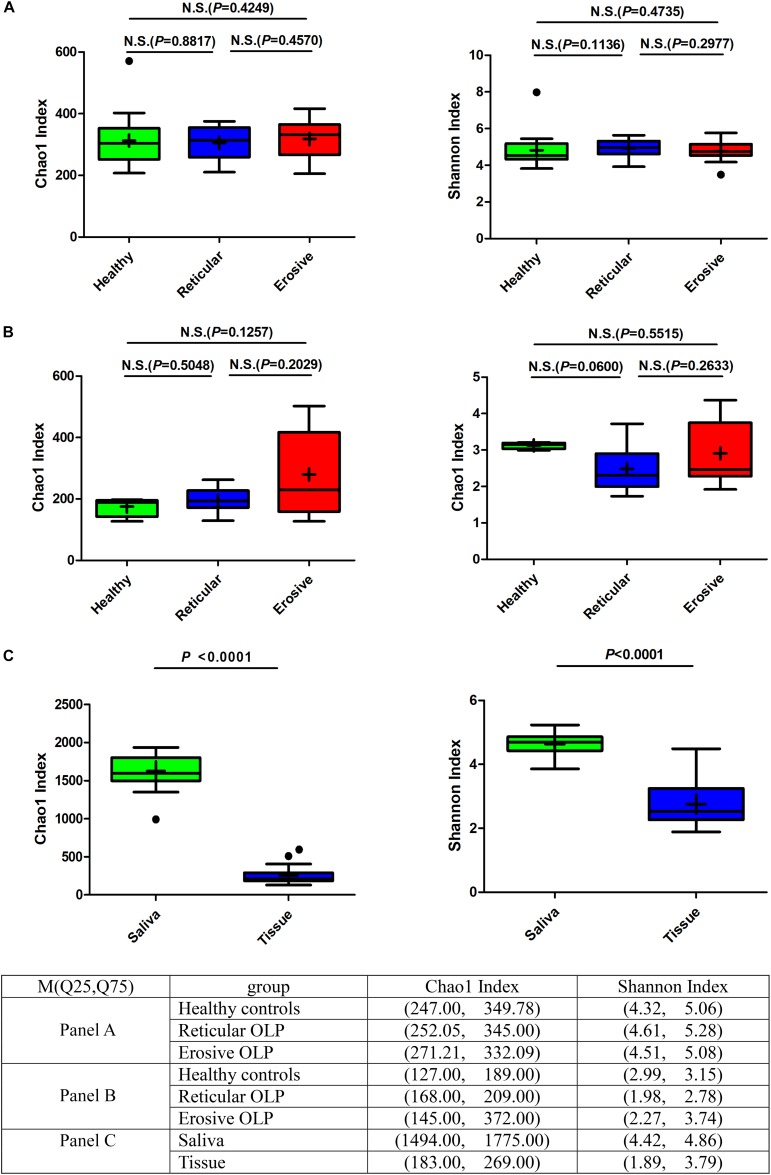
Box plot: Alpha diversity among healthy controls, reticular OLP, and erosive OLP. (A) Chao1 index and Shannon index among healthy controls, reticular OLP, and erosive OLP in saliva samples. (B) Chao1 index and Shannon index among healthy controls, reticular OLP, and erosive OLP in tissue samples. (C) Chao1 index and Shannon index between saliva and tissue samples. Box plots show the top quartile, median, and bottom quartile; “ + ” means the average value and “∙” means the outlier. N.S. means no statistical difference. The P-value was obtained by the Mann–Whitney U-test.